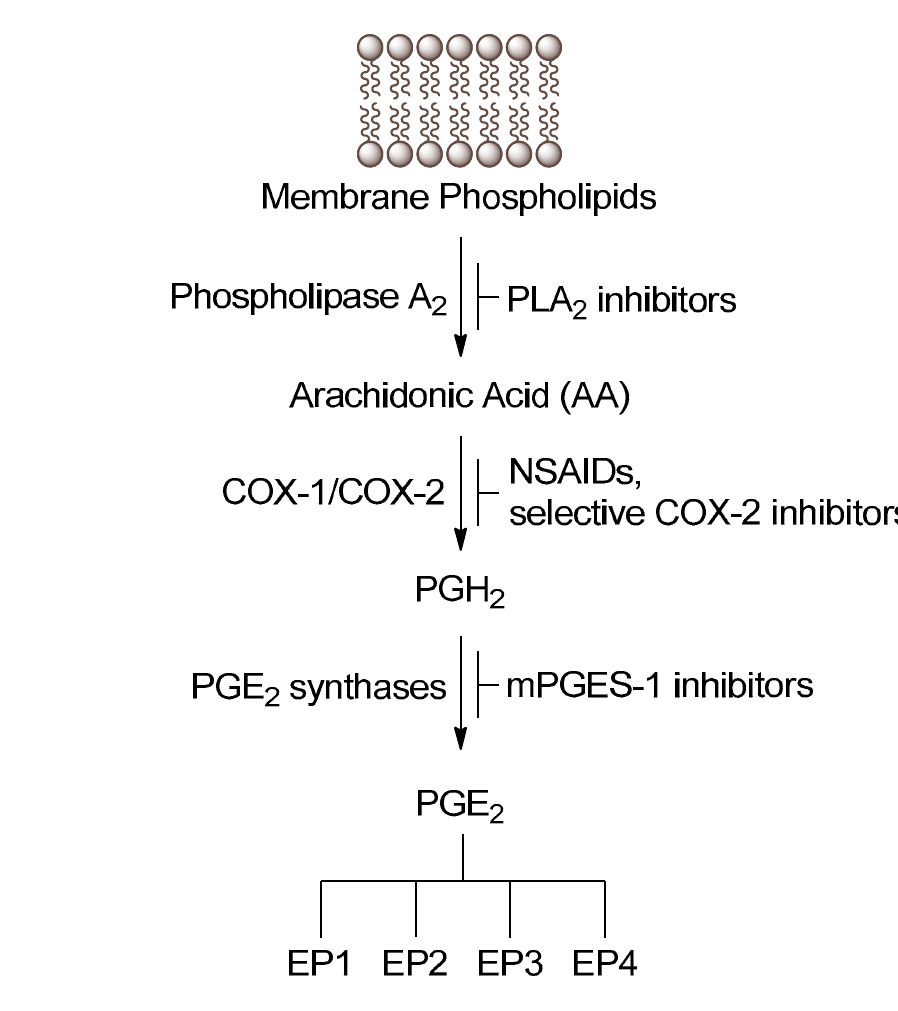
Figure 2. Examples of α -ketothiazoles exhibiting anti-inflammatory properties. 2. Materials and Methods 2.1. General Chemistry Methods Chromatographic purification of products was accomplished using forced-flow chro- matography on Merck ® (Merck, Darmstadt, Germany) Kieselgel 60 F 254 230–400 mesh. Thin-layer chromatography (TLC) was performed on aluminum-backed silica plates (0.2 mm, 60 F 254 ). Visualization of the developed chromatogram was performed by fluores- cence quenching using phosphomolybdic acid, ninhydrin, or potassium permagnate stains. Melting points were determined on a Buchi ® 530 (Buchi, Flawil, Switzerland)